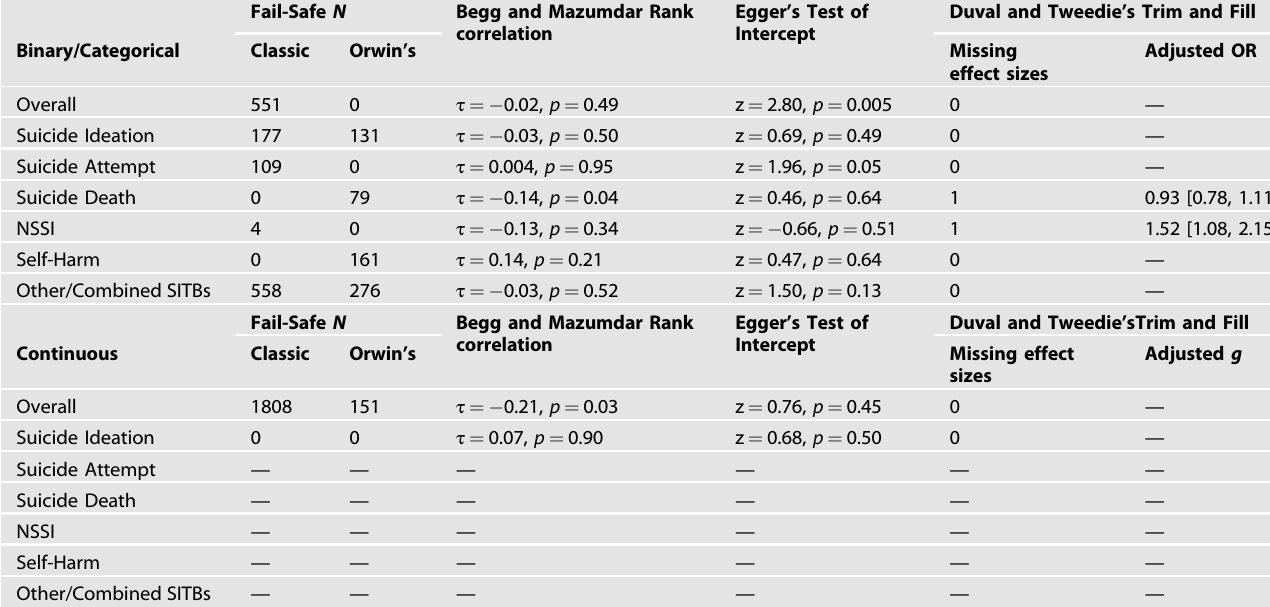
Table 4. Publication